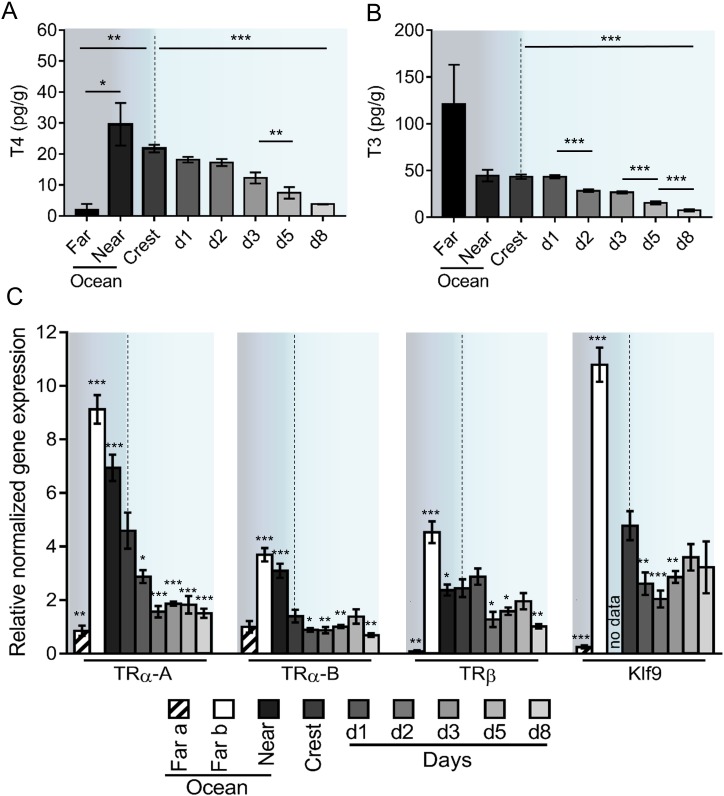
Thyroid hormone signaling during Acanthurus triostegus metamorphosis.Error bars represent standard errors. *p-value<0.05; **p-value<0.01; ***p-value<0.001. (A) T4 and (B) T3 dosage: Y-axis: T4 and T3 levels in pg.g−1; X-axis: sampling point. n = 3 for 5 to 10 km offshore fish (far), n = 5 for 2 km offshore fish (near), n = 297 for crest to day 8 (d8) fish. Statistics: mean comparisons (Wilcoxon-Mann-Whitney U-test). See Figure 2—source data 1 and Figure 2—source data 2 for detailed data and statistics. (C) Expression level of TRα-A, TRα-B, TRβ and Klf9 by qPCR, normalized with Pold2 and Rpl7. Y-axis; Relative normalized expression X-axis: gene and sampling point.. Far ocean larvae are split in two groups: Far a (black stripes) and Far b (white). For each panel, the color shading is the same one as in Figure 1A. For each sampling point three biological replicates and three technical replicates were performed. Statistics: comparisons of each mean to the Crest condition mean (Student's t cumulative distribution function, which was automatically computed by qPCR software CFX Biorad Manager, CFX Manager SH, 2017). See Figure 2—source data 3 for detailed data and statistics.10.7554/eLife.27595.011Figure 2—source data 1.Acanthurus triostegus T4 levels in larvae and juveniles.10.7554/eLife.27595.012Figure 2—source data 2.Acanthurus triostegus T3 levels in larvae and juveniles.10.7554/eLife.27595.013Figure 2—source data 3.TR and Klf9 expression levels in Acanthurus triostegus at different developmental stages (qPCR).10.7554/eLife.27595.014Figure 2—source data 4.Transactivation assay of Acanthurus triostegus TR for several thyroid hormone derivatives.10.7554/eLife.27595.015Figure 2—source data 5.Transactivation assay of Acanthurus triostegus TR for the competition of T3 and NH3.10.7554/eLife.27595.016Figure 2—source data 6.List of primers used in this study.10.7554/eLife.27595.017Figure 2—source data 7.List of TR used for phylogenetic reconstruction.